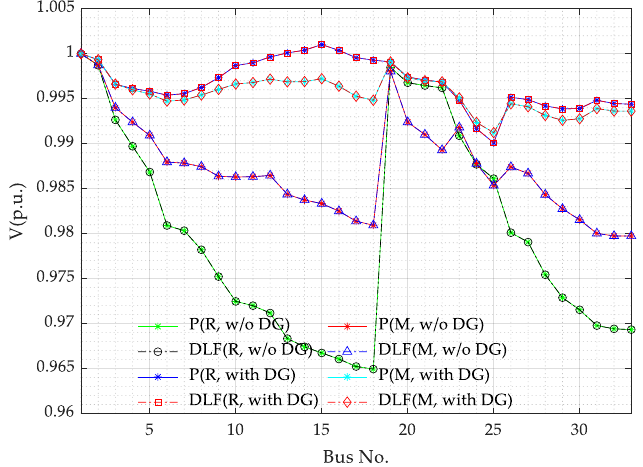
Figure 7. Voltage profile comparison of the 33-node test feeder with and without the penetration of Distributed Generators (DGs) (P = proposed, R = radial, M = meshed, Case 1).